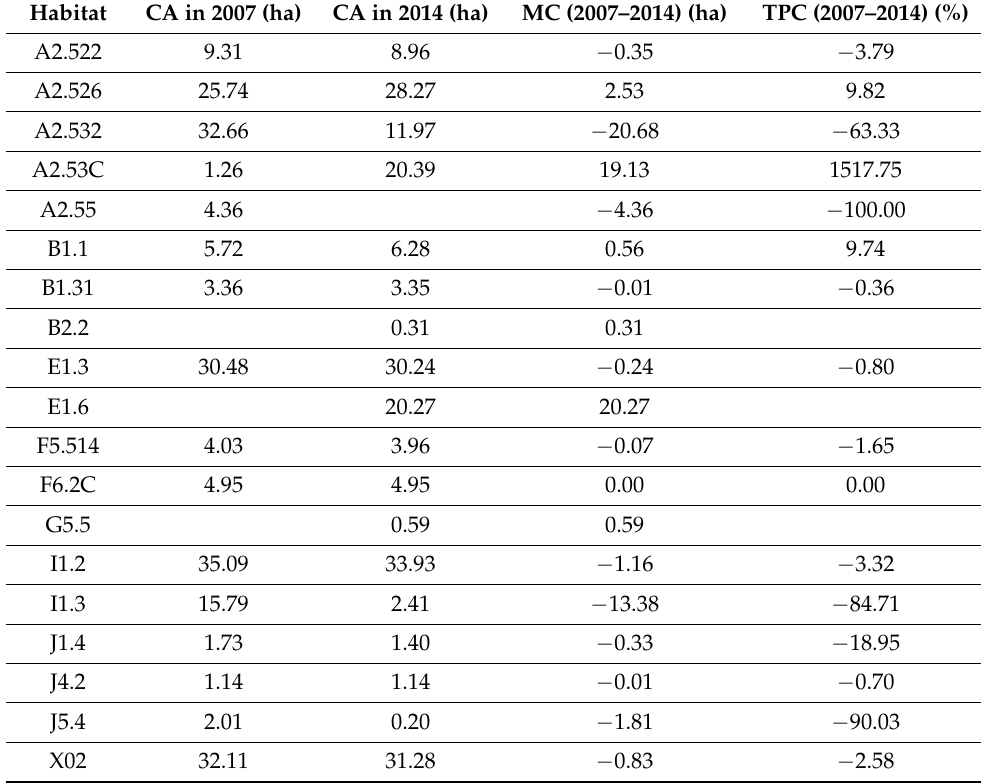
Table 3. Class Area (CA) in 2007 and 2014: Magnitude Change (MC) and Trend Percentage Change (TPC) in the SC site.